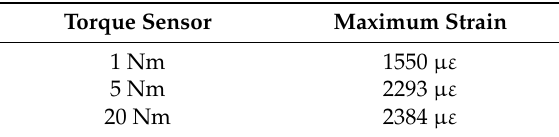
Table 3. Strain of the sensors.